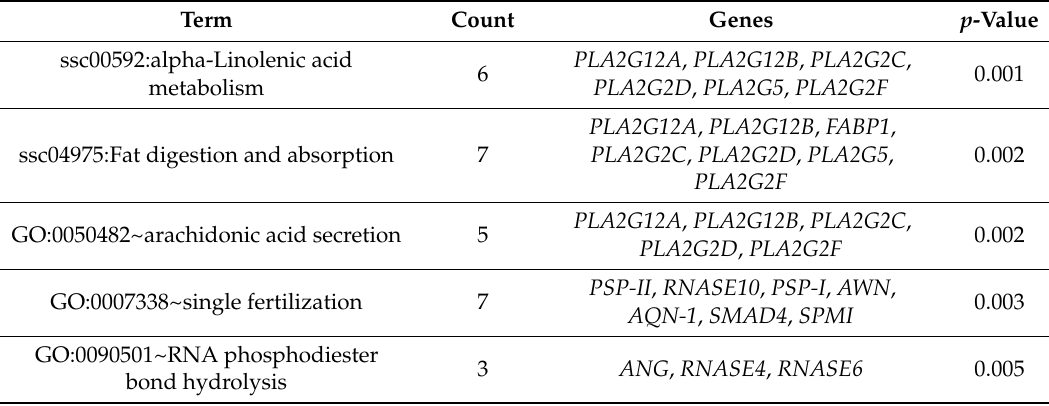
Table 3. Gene Ontology (GO) terms and Kyoto Encyclopedia of Genes and Genomes (KEGG) pathways enriched with candidate genes